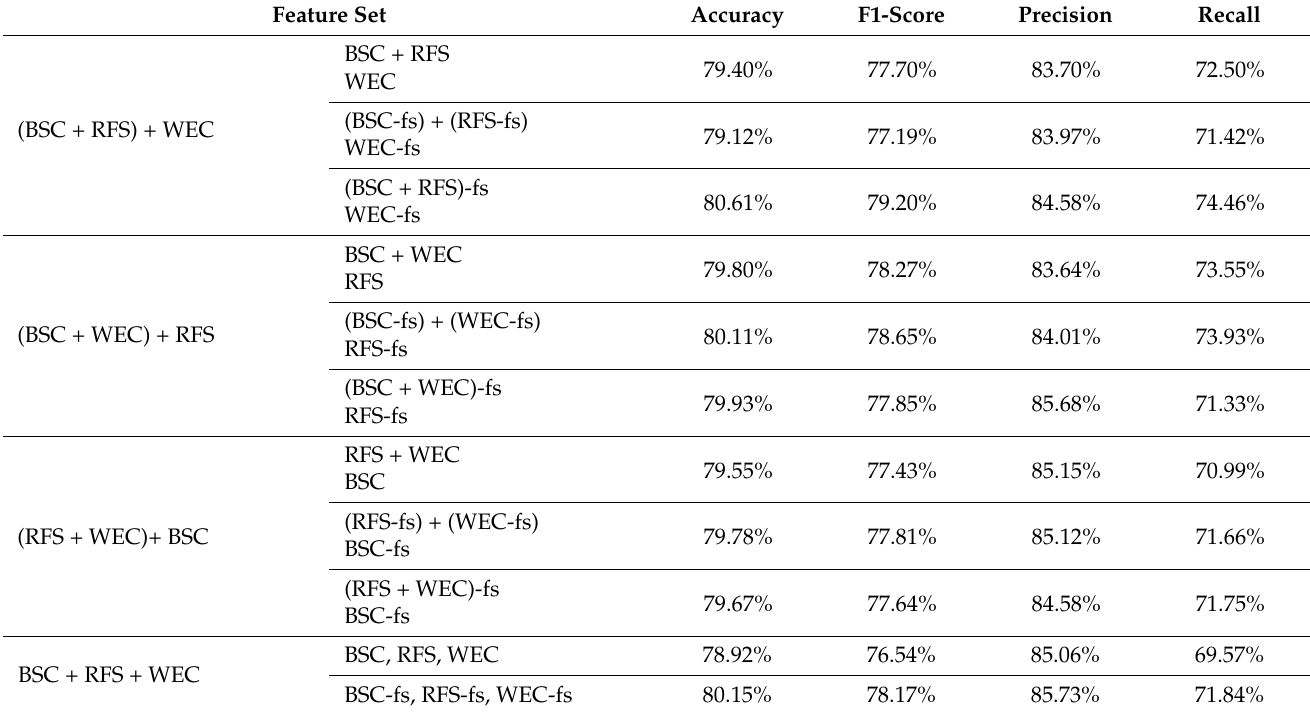
Table 5. Suggested model performance on different feature sets.